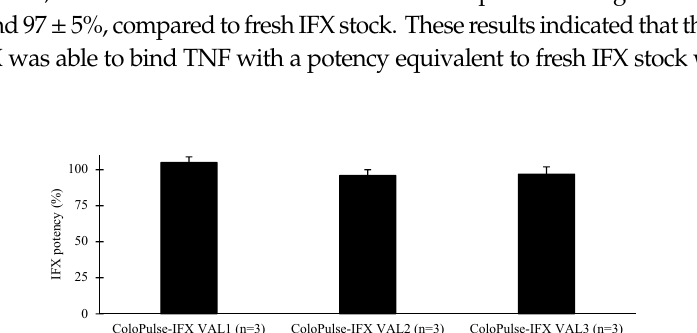
Figure 4. The average ± SD ( n = 3) potency of IFX present in ColoPulse-IFX compared to 5 mg fresh IFX stock (100%) as analyzed with a validated ELISA kit.